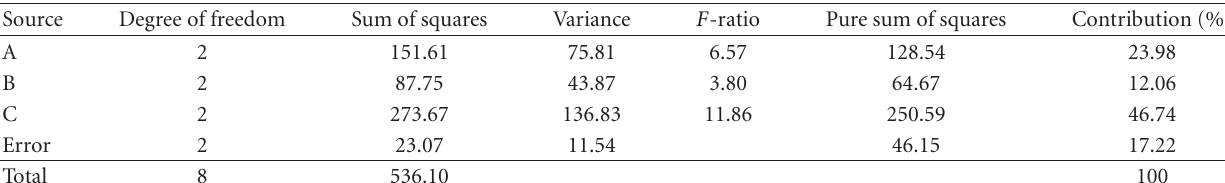
Table 6: ANOVA of SN ratio for the removal rate of